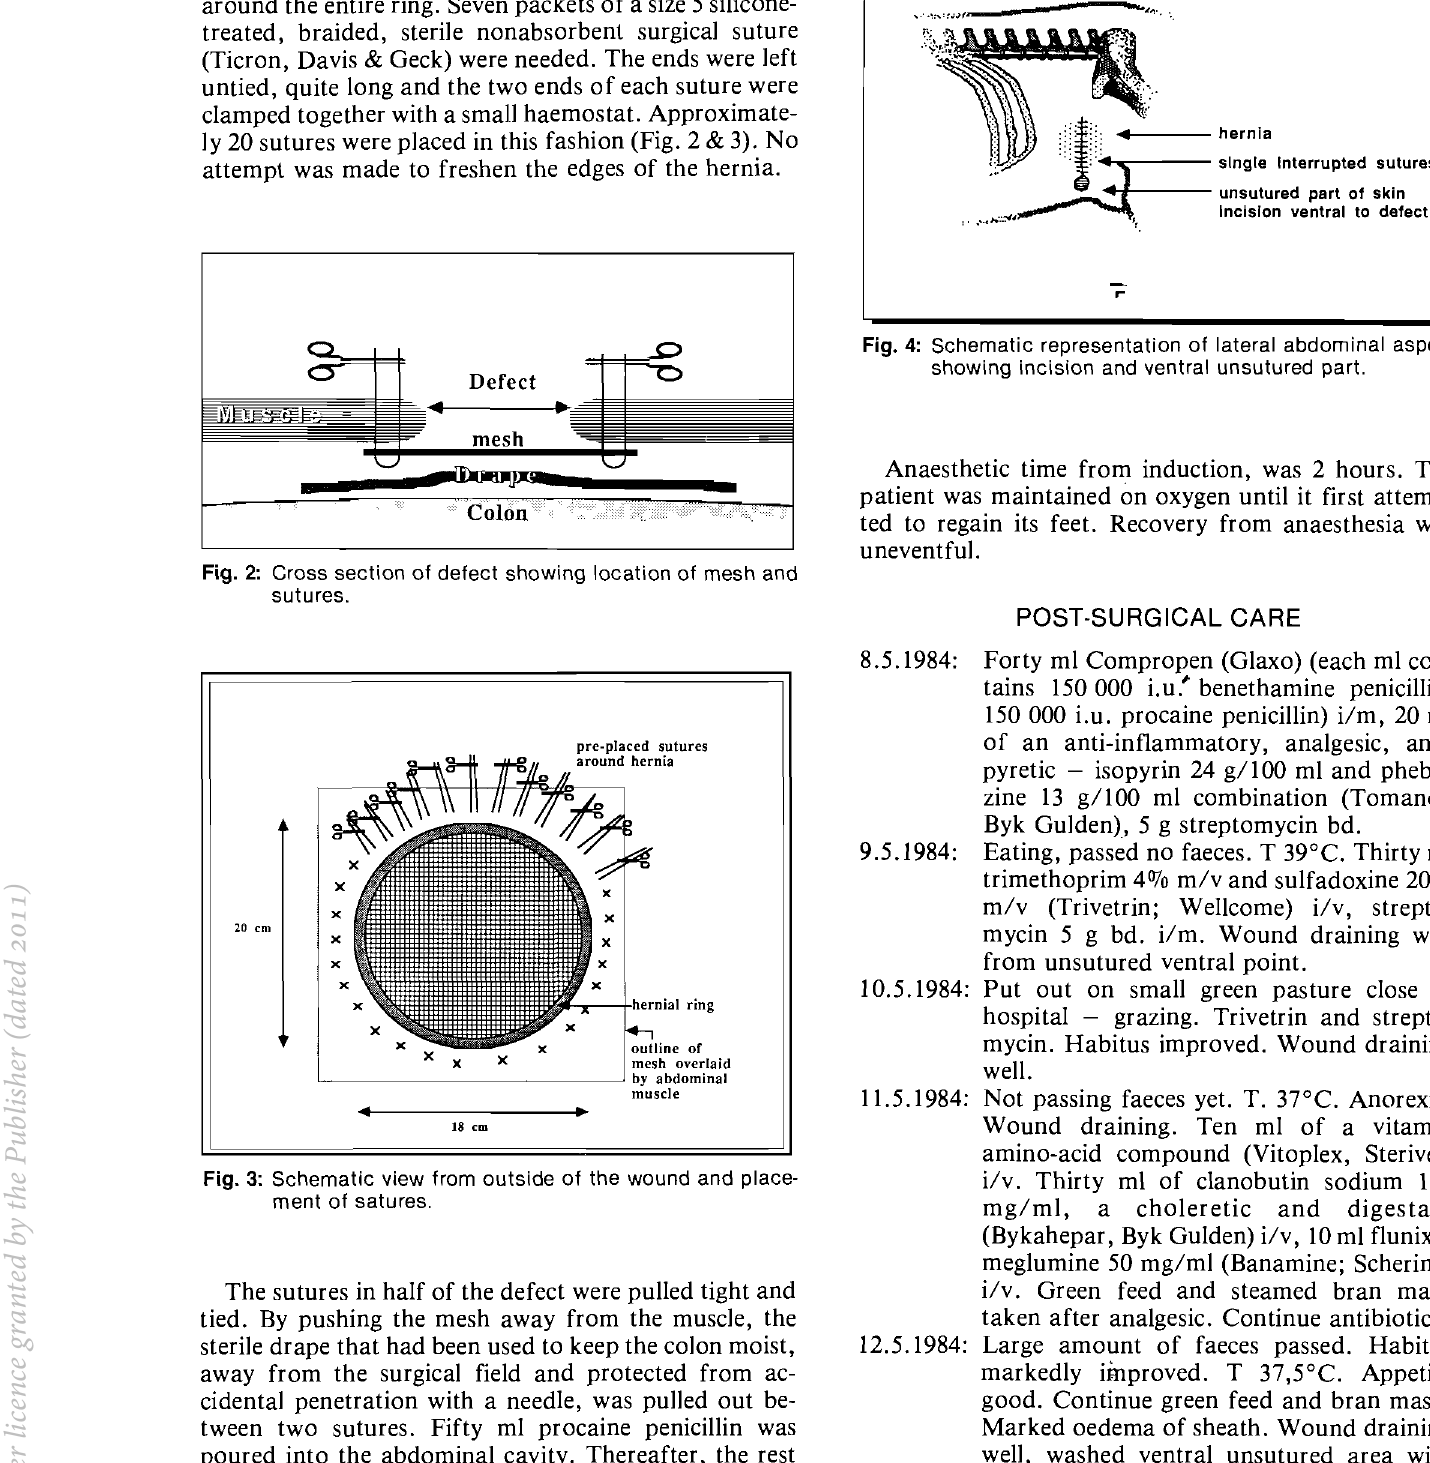
The sutures in half of the defect were pulled tight and tied. By pushing the mesh away from the muscle, the